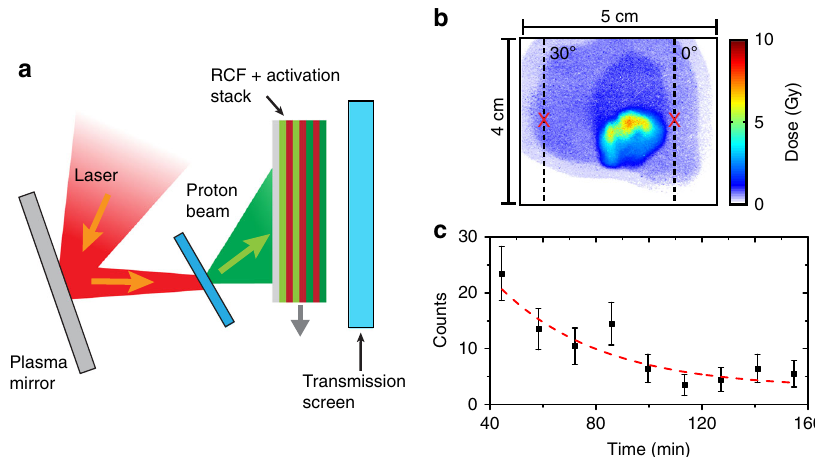
Fig. 1 Schematic of the experiment set-up and example measurements. a A pulse from the Vulcan laser is focused by an f/ 3 off-axis parabola and re fl ected from a planar plasma mirror onto a target foil. The spatial-intensity pro fi le of the beam of accelerated protons is measured using stacked dosimetry fi lm (RCF), interwoven with Cu foils for nuclear activation measurements. The transmitted laser energy is characterised on a transmission screen (with the stack retracted). b Example proton beam dose distribution, as measured using RCF, for proton energies ε p ≥ 89 MeV. The red markers at 0° and 30° correspond to the laser axis and target normal axis, respectively. c Example measurements of the positron-emission decay of the 63 Zn radioisotope produced by proton activation of Cu in the stack ( 63 Cu(p,n) 63 Zn), for protons with ε p > 92 MeV. The time is measured from the time of the laser-plasma interaction and the error bars are determined from the statistical uncertainties in the measured counts. The dashed curve is a fi t corresponding to the 38.5 min half-life of 63 Zn, con fi rming proton-induced activation in the high-energy region of the fi lter stack